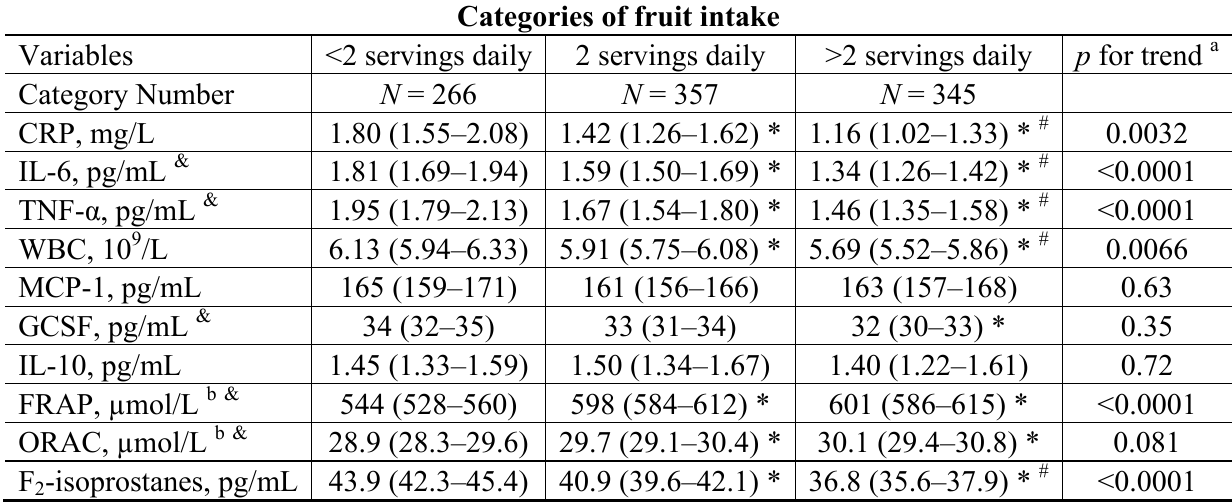
Table 3. Outcome characteristics (least square means (95% confidence interval)) by category of fruit and vegetable intake of community